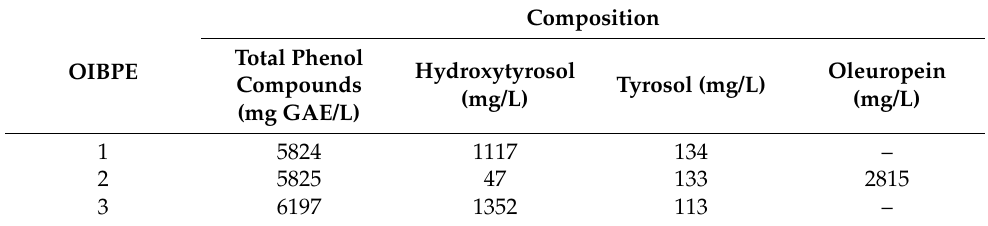
Table 1. Composition of the olive oil industry by-products extracts